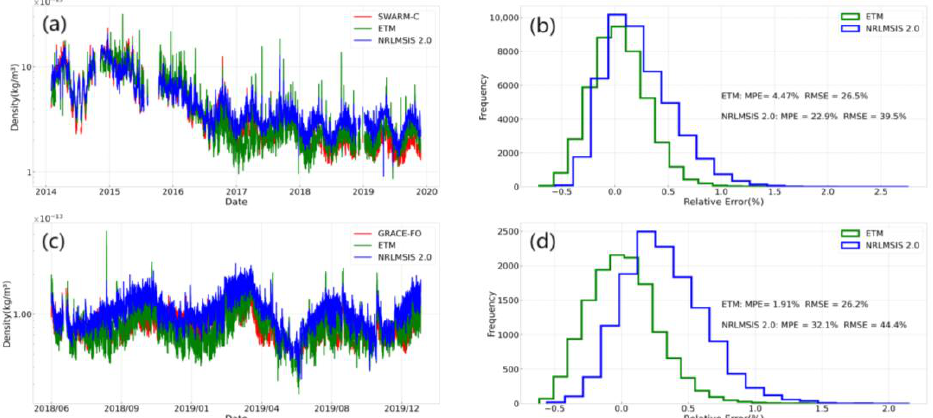
Figure 6. ( a ) two-hours averaged mass density from SWARM-C satellite (red line), ETM results (green line), NRLMSISE 2.0 model (blue line) and ( b ) the statistic distribution of relative errors of one-hour averaged mass density between SWARM-C observations and ETM results (green line) and NRLMSIS 2.0 model results (blue line); ( c ) and ( d ) same as ( a ) and ( b ), but for the GRACE-FO satellite.